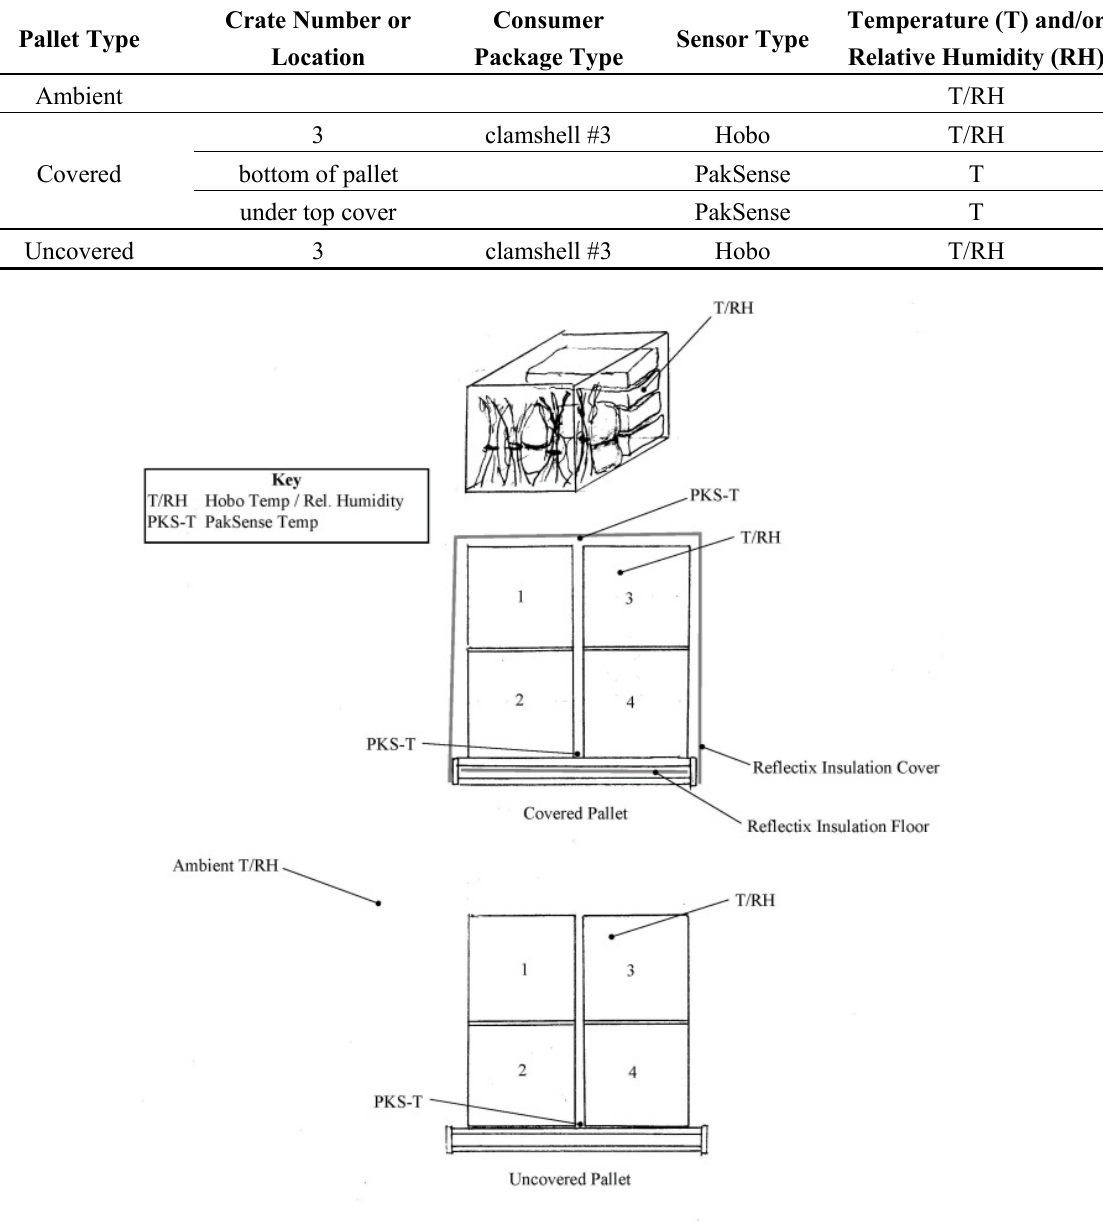
Table 1. Summary of temperature and relative humidity measurements in consumer packages and stacked crates in covered and uncovered pallets during six hours storage under ambient conditions.